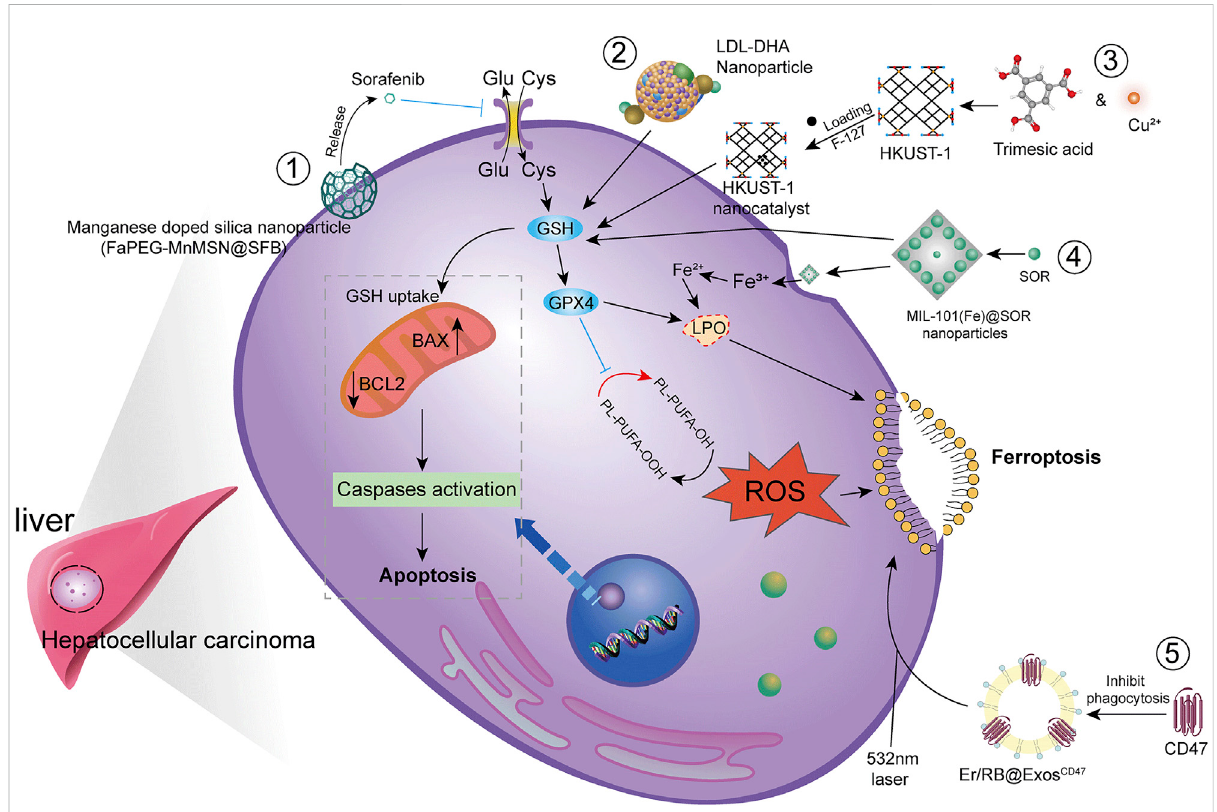
FIGURE 4 Modern technology for the treatment of HCC by ferroptosis. To achieve higher bioavailability by designing nano-encapsulated materials to prevent drug degradation, including 1) silica nanoparticles; 2) low-density lipoprotein nanoparticles; 3) metal-organic framework compound materials MOF + nanocatalyst HKUST-1; 4) iron-containing Ionic MIL-101(Fe)NPs. In addition, chemophotodynamic therapy 5) combined with exosome use induces